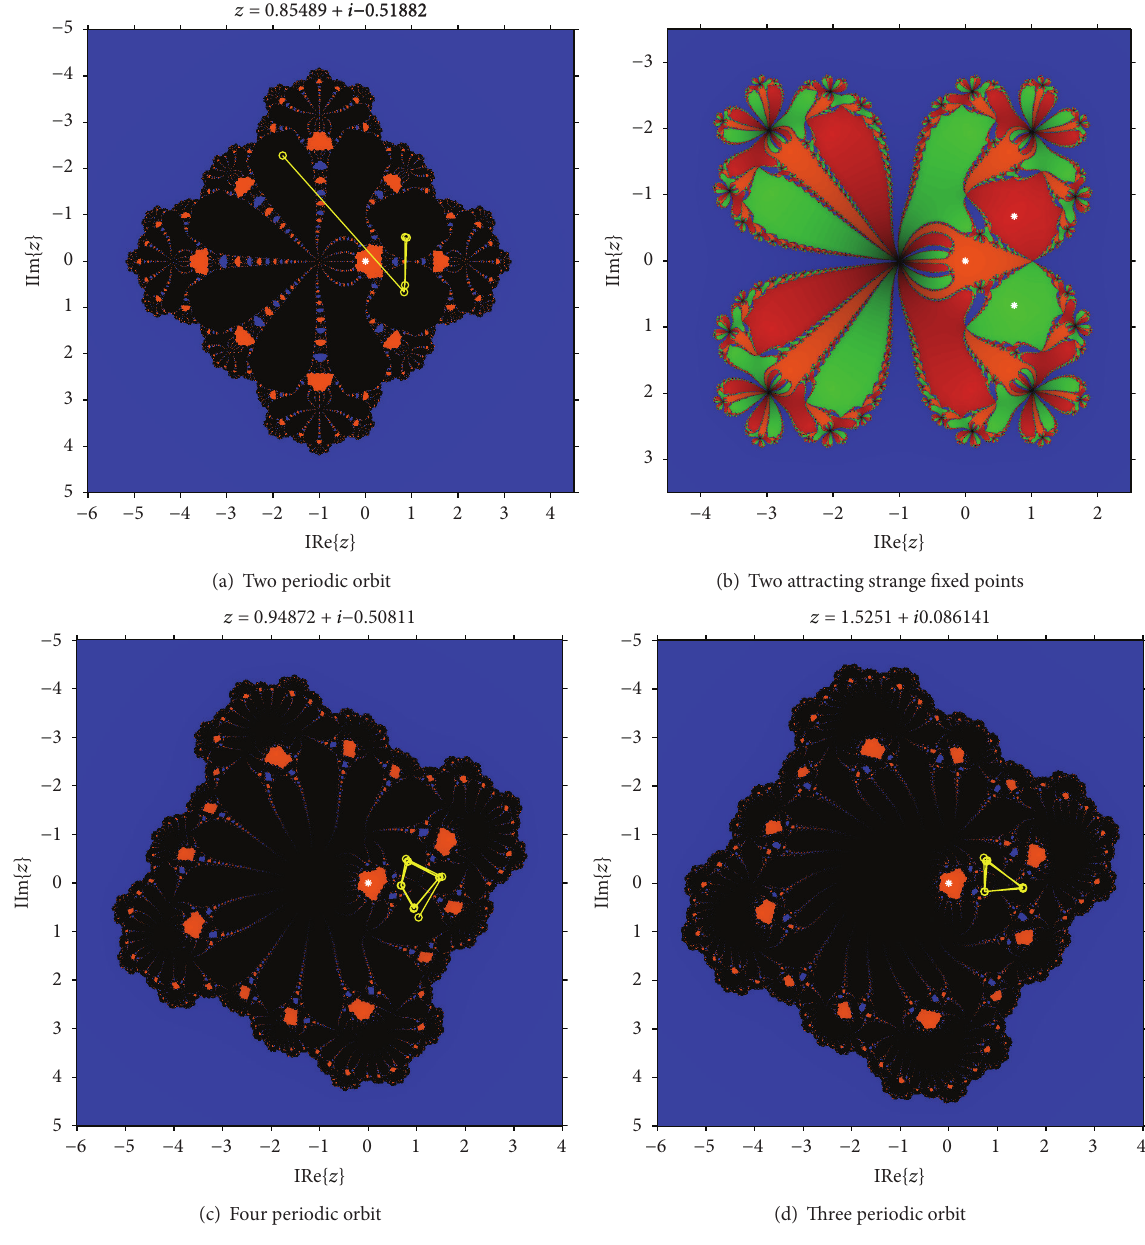
Figure 6: Some dynamical planes from 𝑃 2